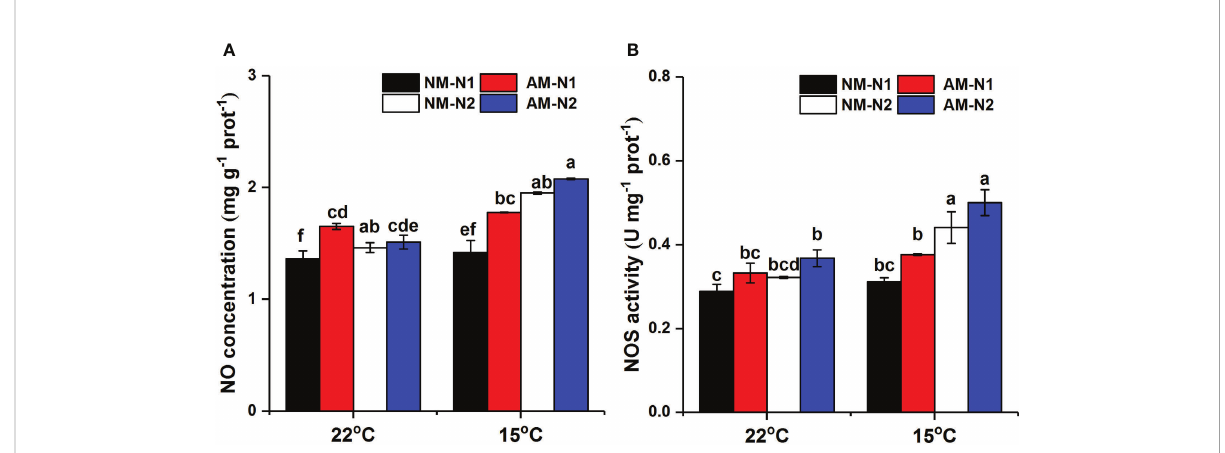
FIGURE 5 Nitric oxide (NO) (A) concentration and nitric oxide synthase (NOS) activity (B) of non-mycorrhizal and mycorrhizal rice treated with different temperatures and N levels. Abbreviations are de fi ned in Figure 4. Values are the means ± standard errors of three biological replicates. Different